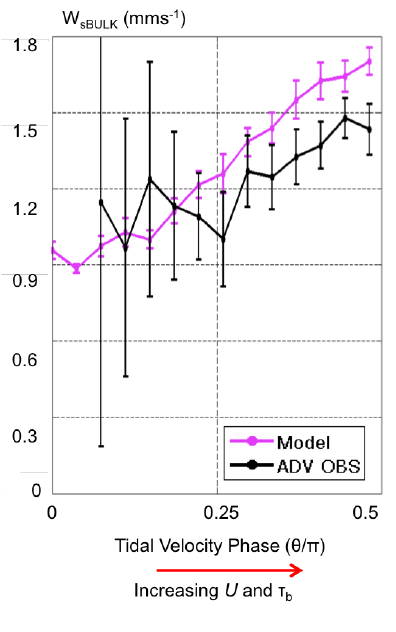
Figure 7. ADV and model estimated (see legend) bulk settling velocity during periods of increasing tidal velocity for the top 20% of tidal cycles with the highest bed stresses. Error bars denote ±1 standard